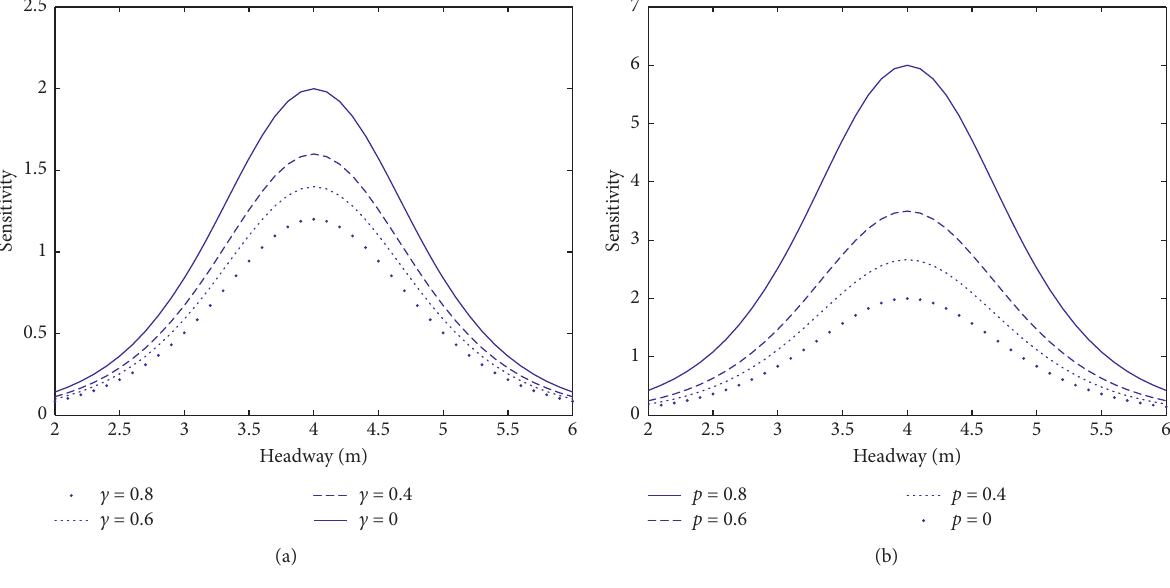
Figure 5: Critical stability curves: (a) for model 1; (b) for model 2.